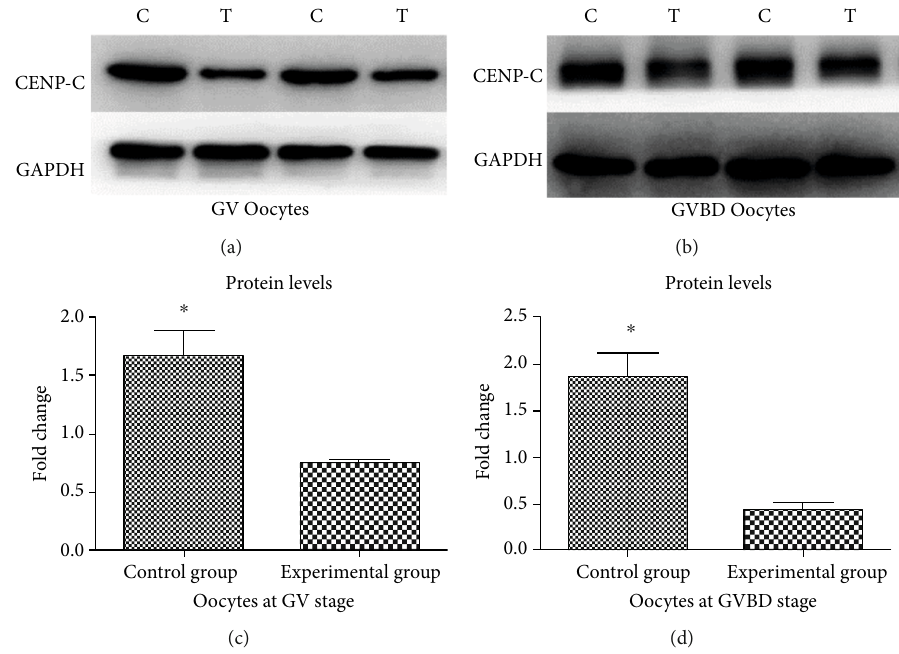
Figure 3: CENP-C protein in oocytes. Western blotting of CENP-C protein in total protein extracted from GV oocytes (a) and oocytes at the GVBD stage (b). The membranes were cut prior to exposure so that only the portion of gel containing desired bands would be visualized. C: control group; T: experimental group. Quanti fi cation of CENP-C protein in oocytes at the GV stage (c) and GVBD stage (d). ∗ P < 0 : 05 , ∗∗ P < 0 : 01 .